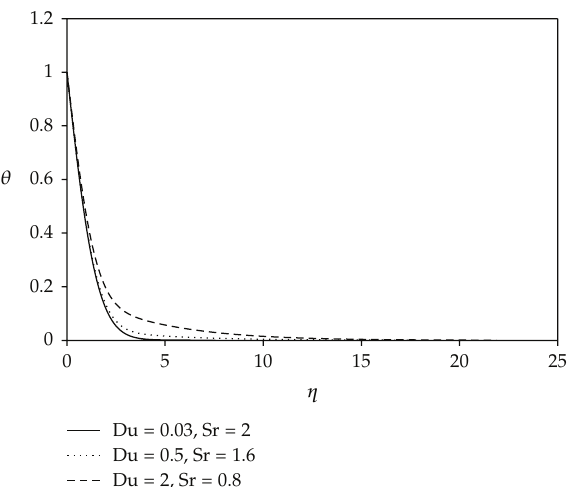
Figure 2: Temperature profile for di ff erent values of Dufour and Soret for θ r (cid:8) 5, N (cid:8) 1, Le (cid:8) 0 . 1, Pr (cid:8) 0 . 71, and Sc (cid:8) 0 . 1.